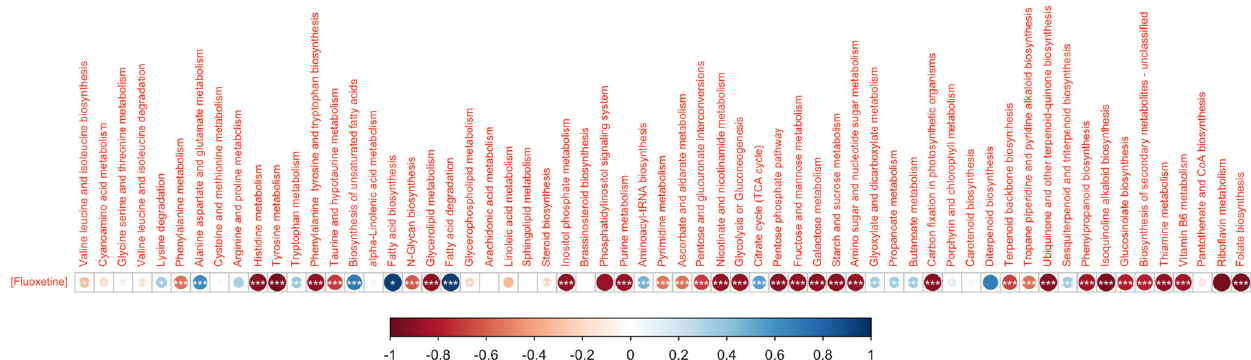
Figure 9. Spearman correlogram between the evaluated metabolic pathways and the exogenous fluoxetine concentration applied to the diatom cultures (asterisks denote significant correlations at * p < 0.05, ** p < 0.01 and *** p < 0.001).